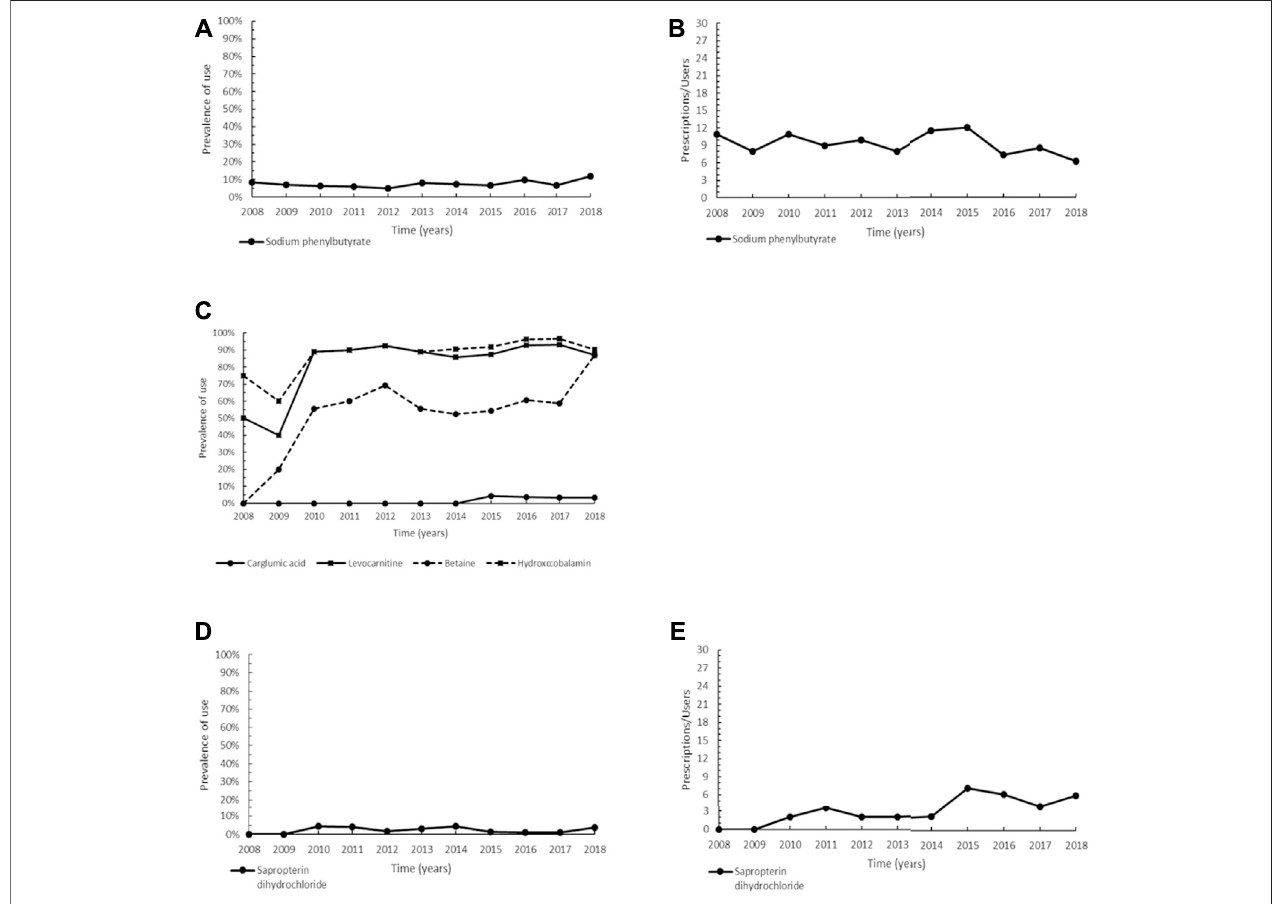
FIGURE2| Trendofprevalence(graphs (A,C,D) )andintensityofuse(graphs (B,E) )ofsodiumphenylbutyrateindicatedforureacycledisorders,oftheorphandrug carglumicacidandlevocarnitine,betaineandhydroxycobalaminindicatedformethylmalonic acidemia,andofsapropterindihydrochlorideindicatedforphenylketonuria. Prevalenceofuse:ratiobetweenthenumber ofcaseswithat leastoneprescriptionandthenumberofprevalentcasesatthebeginning ofeachyear.Prescription/users: ratio between the number of prescriptions of each medication for the total number of patients with at least one dispensing per year.